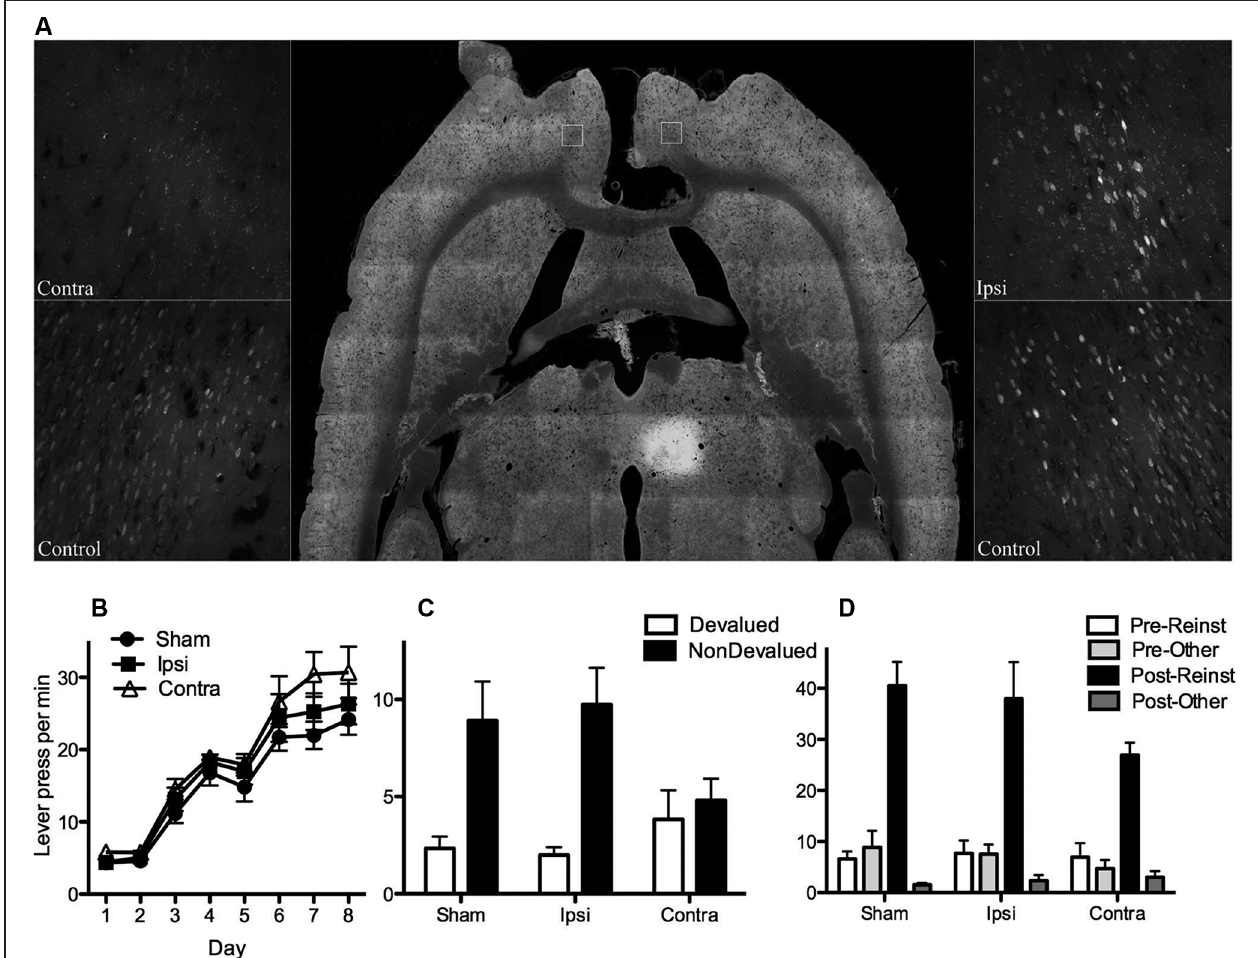
responding per min during outcome devaluation testing. Groups did not differ in overall responding, F (1, 19) = 1.19, p = .29, but there was a main effect of devaluation (averaged over group), F (1, 19) = 18.54, p = .00. There was a significant interaction, F (1, 19) = 5.79, p = .026, suggesting that both the control groups responded selectively on the nondevalued lever relative to the devalued lever (simple effects: Group Sham, F (1, 19) = 10.08, p = .008, Group Ipsi, F (1, 19) = 14.76, p = .001) but that Group Contra responded equally on both levers (simple effect: F (1, 19) = .24, p = .63). (D) Mean ( ± SEM) lever press responding per min during outcome-induced reinstatement testing. There was a main effect of reinstatement, F (1, 19) = 105.38, but no group x reinstatement interaction, F (1, 19) = 3.88, p = .065. Although this interaction might be considered marginal, simple effects show that rats in each group pressed the reinstated lever more than the other lever on test, Group Sham, F (1, 19) = 54.31, p = .00, Group Ipsi, F (1, 19) = 39.6, p = .00, and Group Contra, F (1, 19) = 17.81, p =